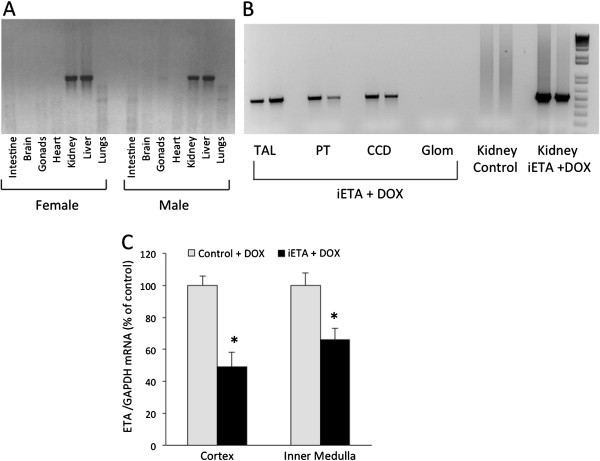
Specificity and sites of ETA receptor KO. Panel A shows a representative blot (N = 6 each gender) of PCR for ENDRA gene recombination, demonstrating Cre activity in liver and kidney. Panel B shows a representative blot (N = 8) of PCR for ENDRA gene recombination in microdissected thick ascending limb (TAL), proximal tubule (PT), cortical collecting duct (CCD) and glomeruli from Pax8-rtTA/LC1/floxed ETA (iETA) mice treated with doxycycline (DOX) (separate mice shown in each lane). Negative (homozygous floxed ETA (control)) and positive (iETA + DOX) PCR of whole kidney DNA are shown. Panel C shows real-time PCR of ETA mRNA (normalized to GAPDH mRNA) in cortex and inner medulla from control + DOX and iETA + DOX mice (N = 8 each group). *p < 0.05 vs. control + DOX.